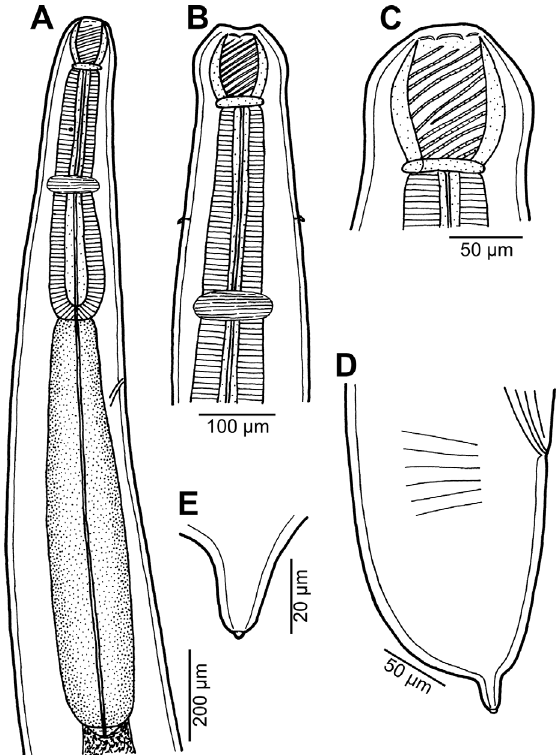
Figure 14. Procamallanus ( Spirocamallanus ) sp. 3 from Laticauda saintgironsi , subgravid female. (A, B) Anterior end, lateral and dorsoventral views, respectively; (C) buccal capsule, lateral view; (D) tail, lateral view; (E) tail tip, lateral view.